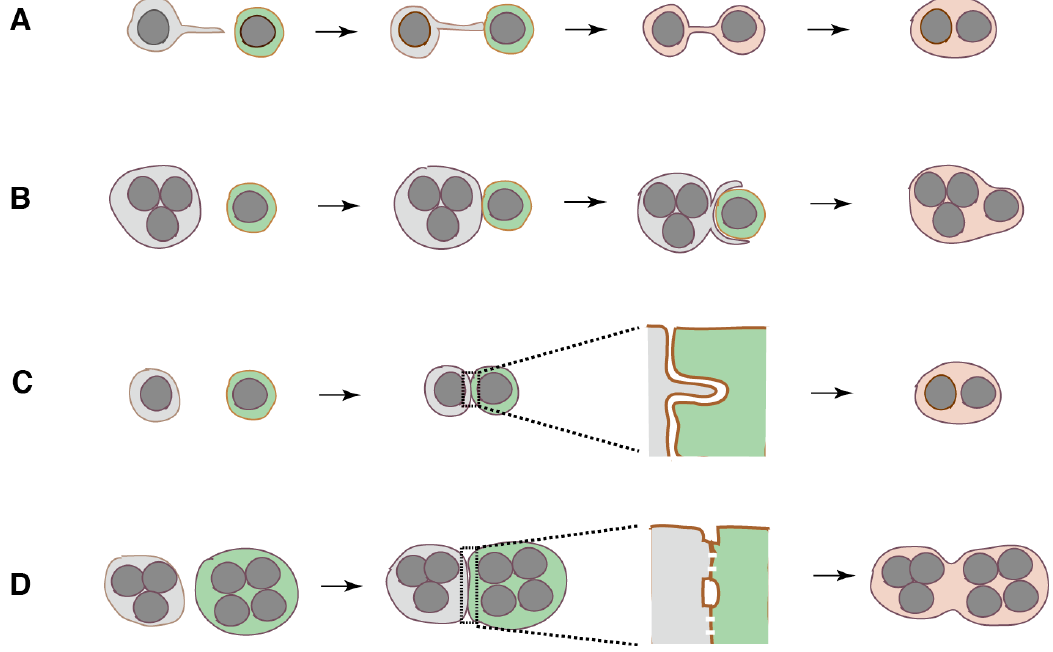
Figure 3. Four types of actin-based linkage between fusion precursors. ( A ), Filopodia-like tube. ( B ), Phagocytic cup-like structure. ( C ), Invasive protrusion. ( D ), Zipper-like